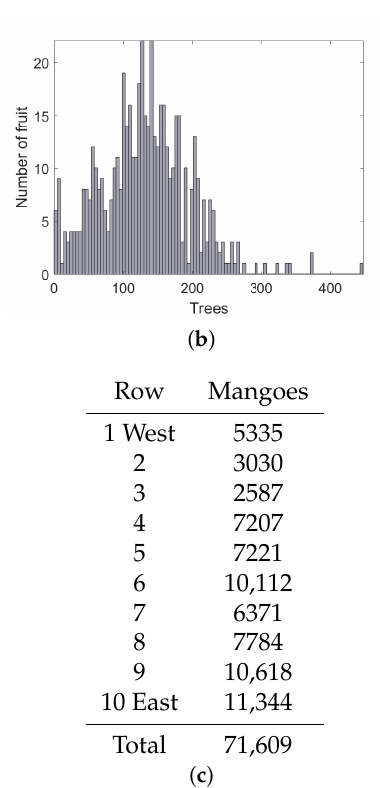
Figure 14. Spatial fruit statistics from the proposed multi-view method: ( a ) yield map of the orchard block, coloured by the number of fruit per tree; ( b ) histogram of fruit per tree; and ( c ) the estimated number of of mangoes for each row and the total. The first three rows have significantly lower yield because of the placement of a shed near the south end. The yield on the other seven similar length rows varies significantly, from 6371 to 11,344. The unproductive block in the southwest corner was removed after these experiments.